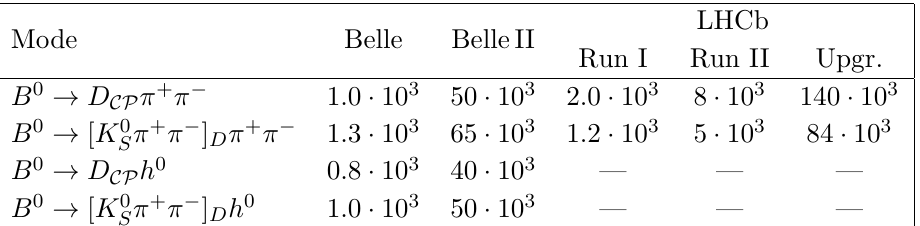
Table 2 . Estimates of the signal yields for the B 0 -conjugated) decays at the Belle, Belle II and LHCb C